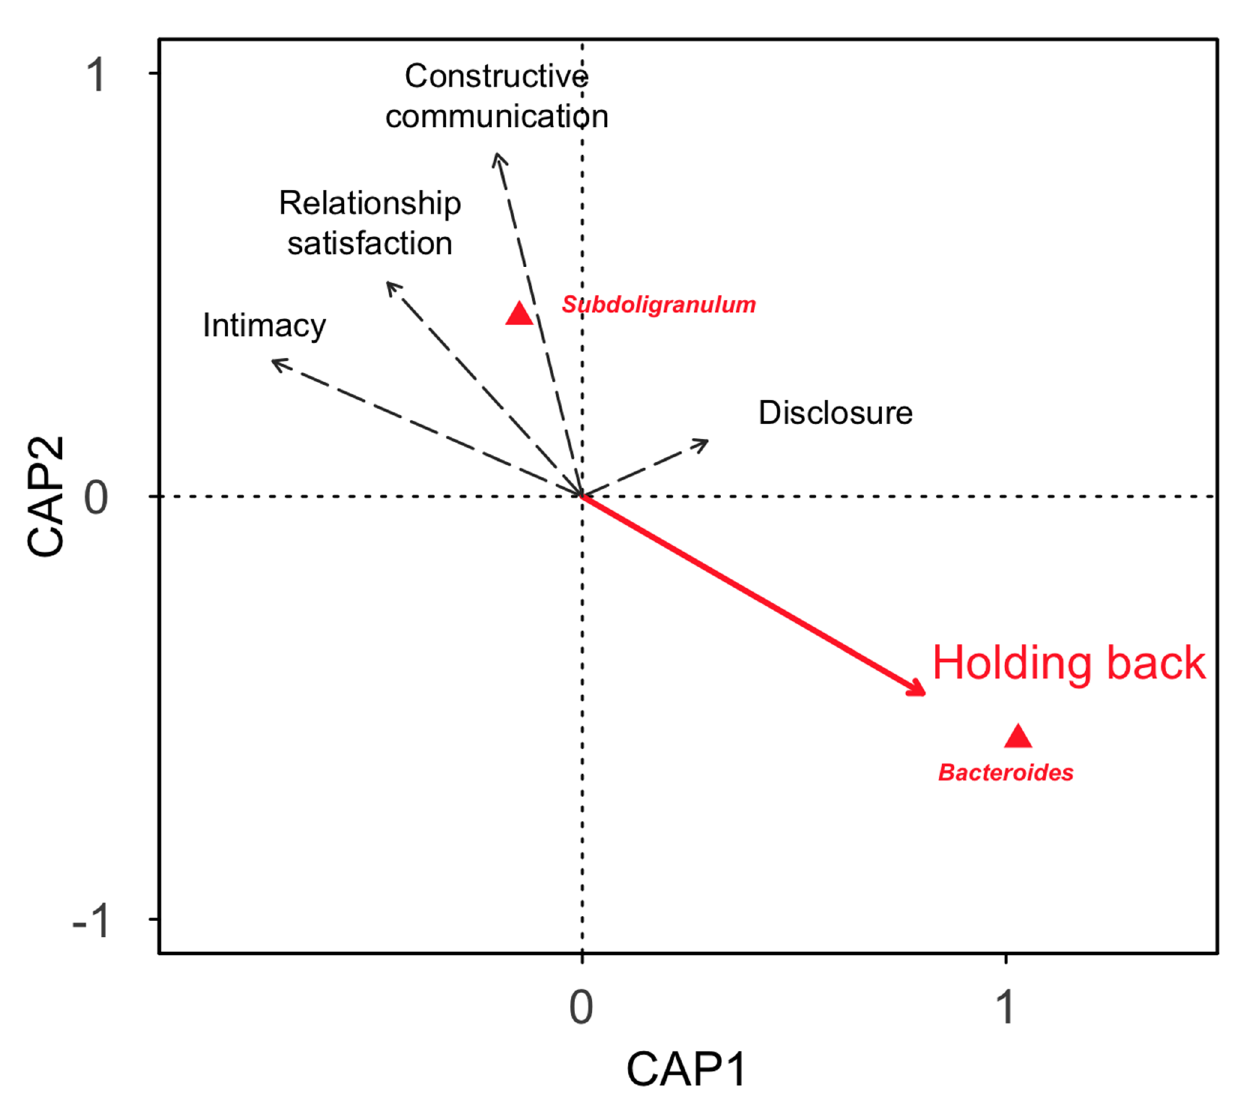
Figure 4. Distance-based redundancy analysis (Bray–Curtis) showing the impact of psychosocial characteristics on the gut microbial composition in older adult couples. The red solid vector represents the psychosocial characteristic (i.e., holding back) that remained after “ordiR2step” variable selection, and the black dashed vectors represent other non-selected psychosocial characteristics. The red triangles and italic labels represent amplicon sequence variants (ASVs) potentially associated with holding back. The other demographic (income, gender) and disease (supplement use) variables were set as conditional